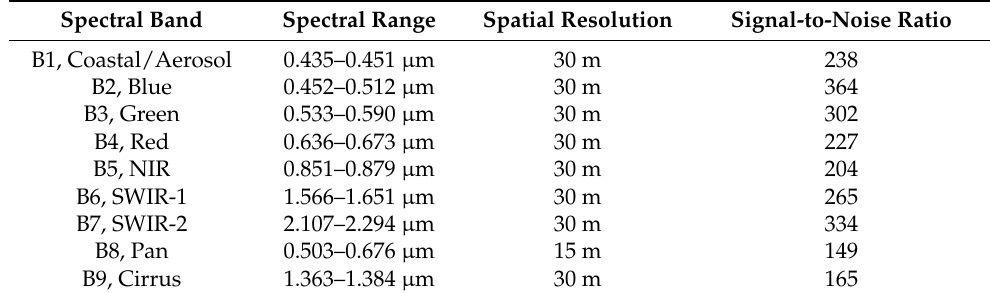
Table 1. Operational Land Imager (OLI) spectral band characteristics. Adapted from the Landsat 8 Data Users Handbook